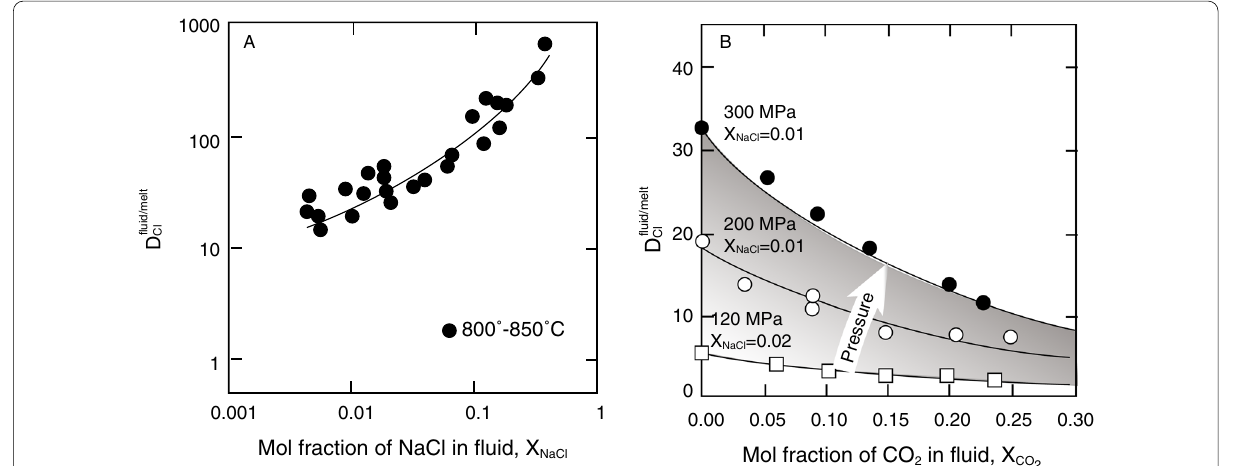
fluid / melt Cl A . as a function of mol fraction of NaCl in fluid at two different temperatures as